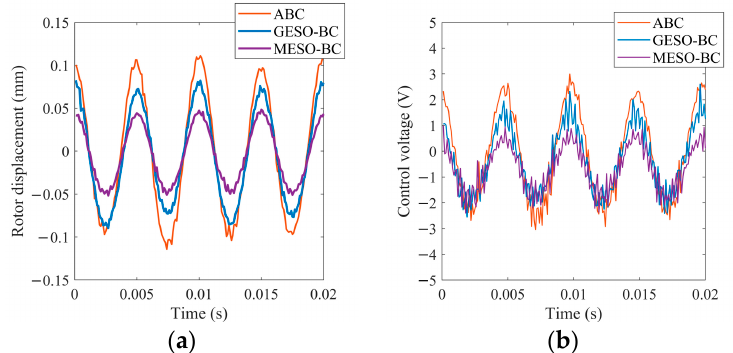
Figure 13. Response waveforms under 6 N sinusoidal disturbance experiments: ( a ) Rotor displacement; ( b ) control voltage.